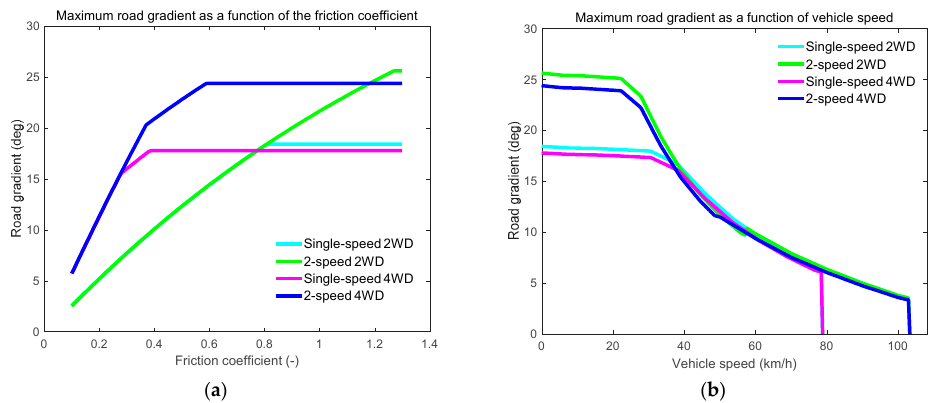
Figure 14. Gradeability performance characteristics: ( a ) Maximum achievable road gradient from standstill as a function of the available tire-road friction coefficient; ( b ) Maximum achievable road gradient as a function of vehicle speed, in high tire-road friction conditions.